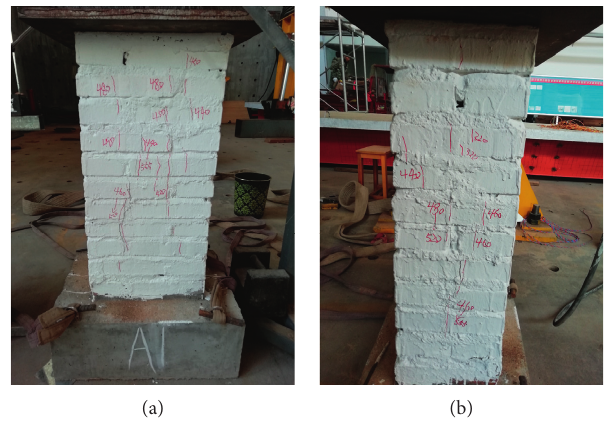
Figure 6: Typical failure of group ZA.